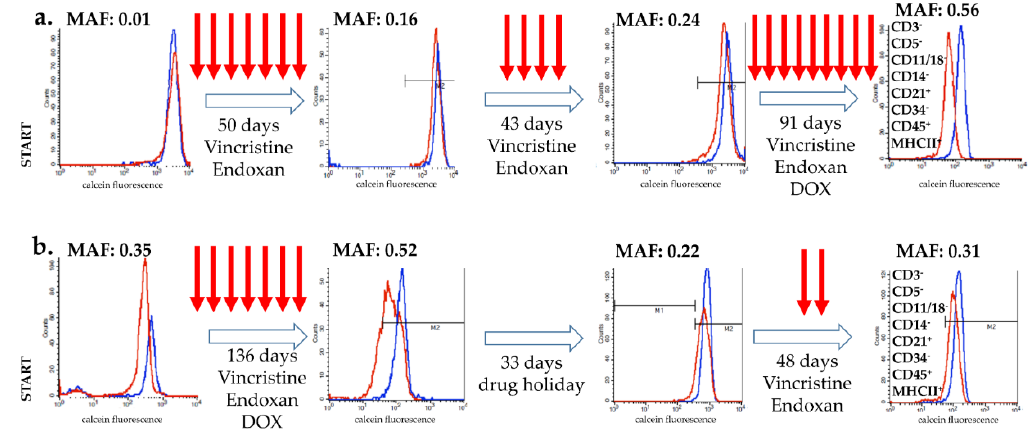
Figure 1. Changes in P-glycoprotein function during chemotherapy in two B-cell lymphoma canine patients. P-glycoprotein activity, as determined by the calcein assay (MAF values), was monitored during therapy (treatments are indicated by arrows). Flow cytometry histograms show the calcein fluorescence of cancer cells incubated with (blue) and without (red) the Pgp inhibitor verapamil. ( a ) Patient 1 showed the typical kinetics of acquired multidrug resistance. ( b ) In the case of Patient 2, MDR was reversed by a 33-day-long (unplanned) drug holiday. The immunophenotype of the lymphoma remained identical during the treatment in both case (results show data of the final measurement).